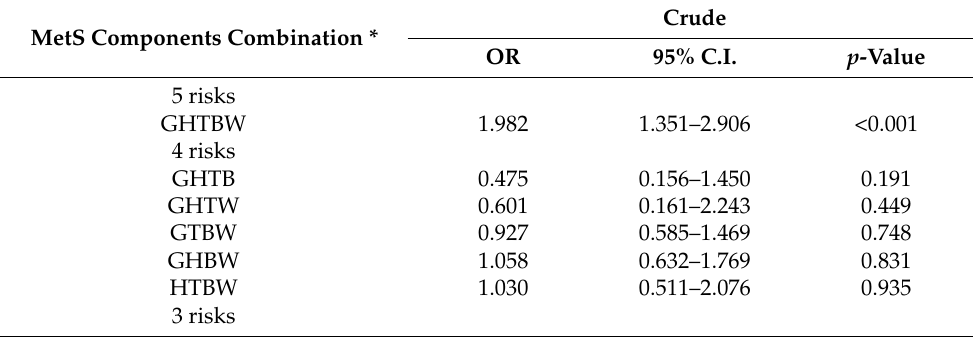
Table 3. The odds ratio and p -Value of specific clusters of MetS